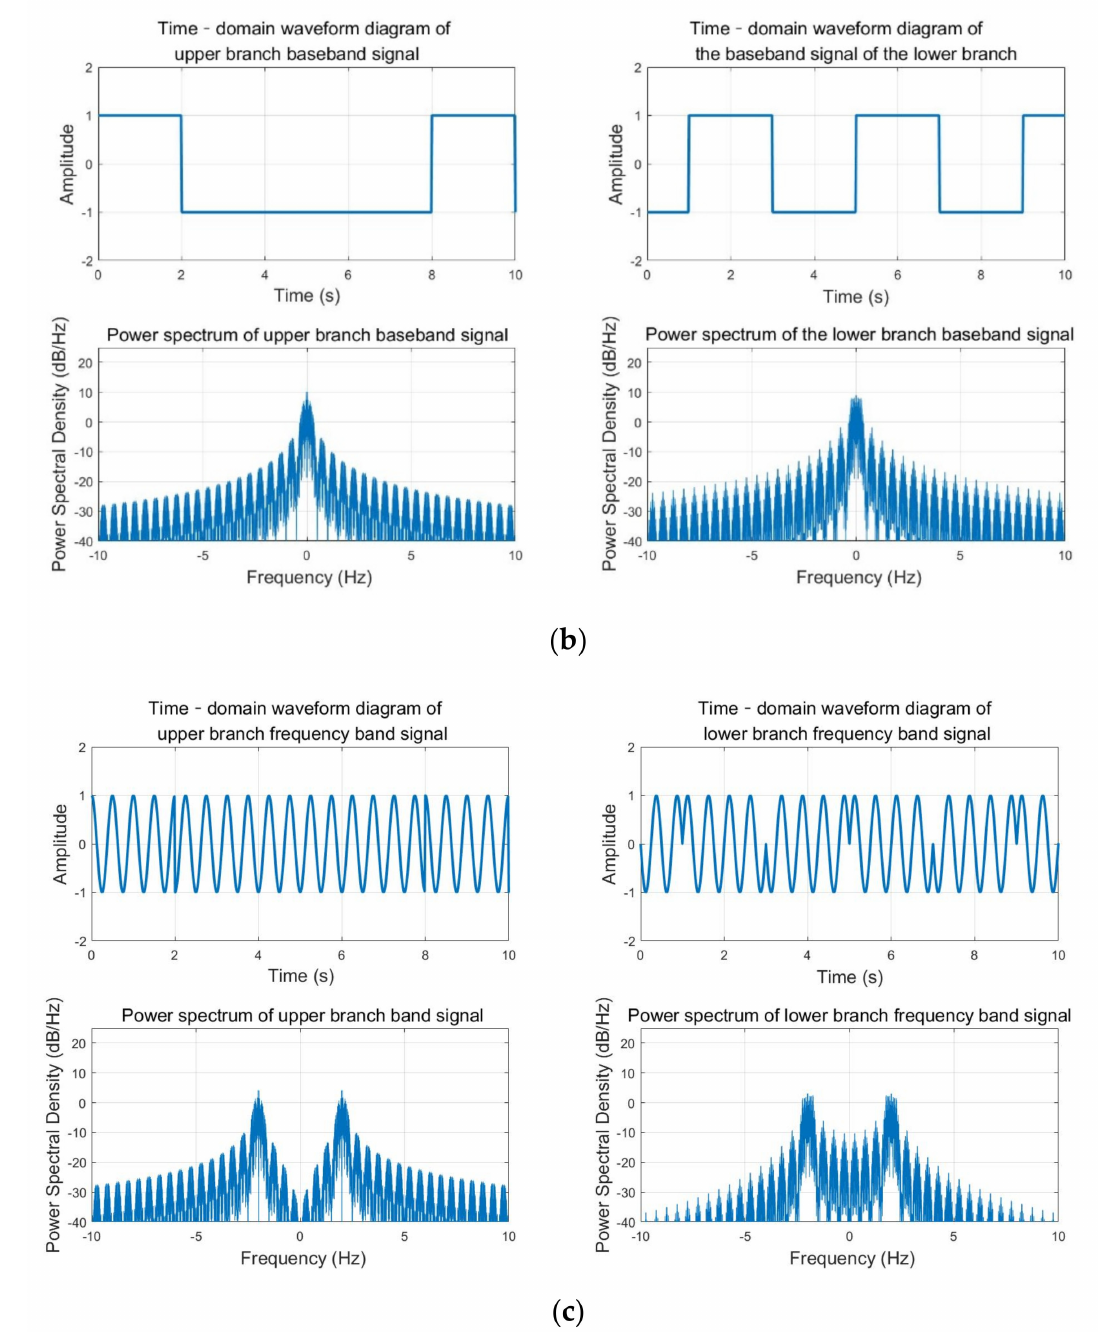
Figure 18. Signal performance diagram. ( a ) Time domain surface plot and power spectrum plot of baseband signal and carrier signal; ( b ) The time-domain waveform and power spectrum of the baseband signal of the upper and lower branches; ( c ) Time-domain waveform and power spectrum of the frequency band signal of the upper and lower